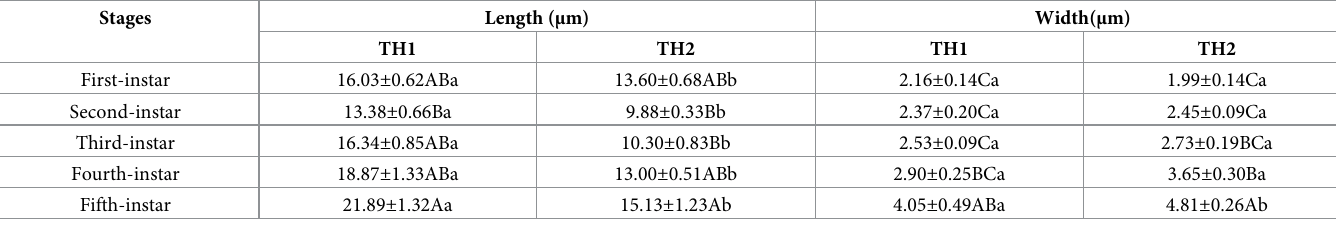
Table 3. Length and width (mean ± SE, n = 10) of TH1 and TH2 of the five nymphal stages of Diaphorina citri .